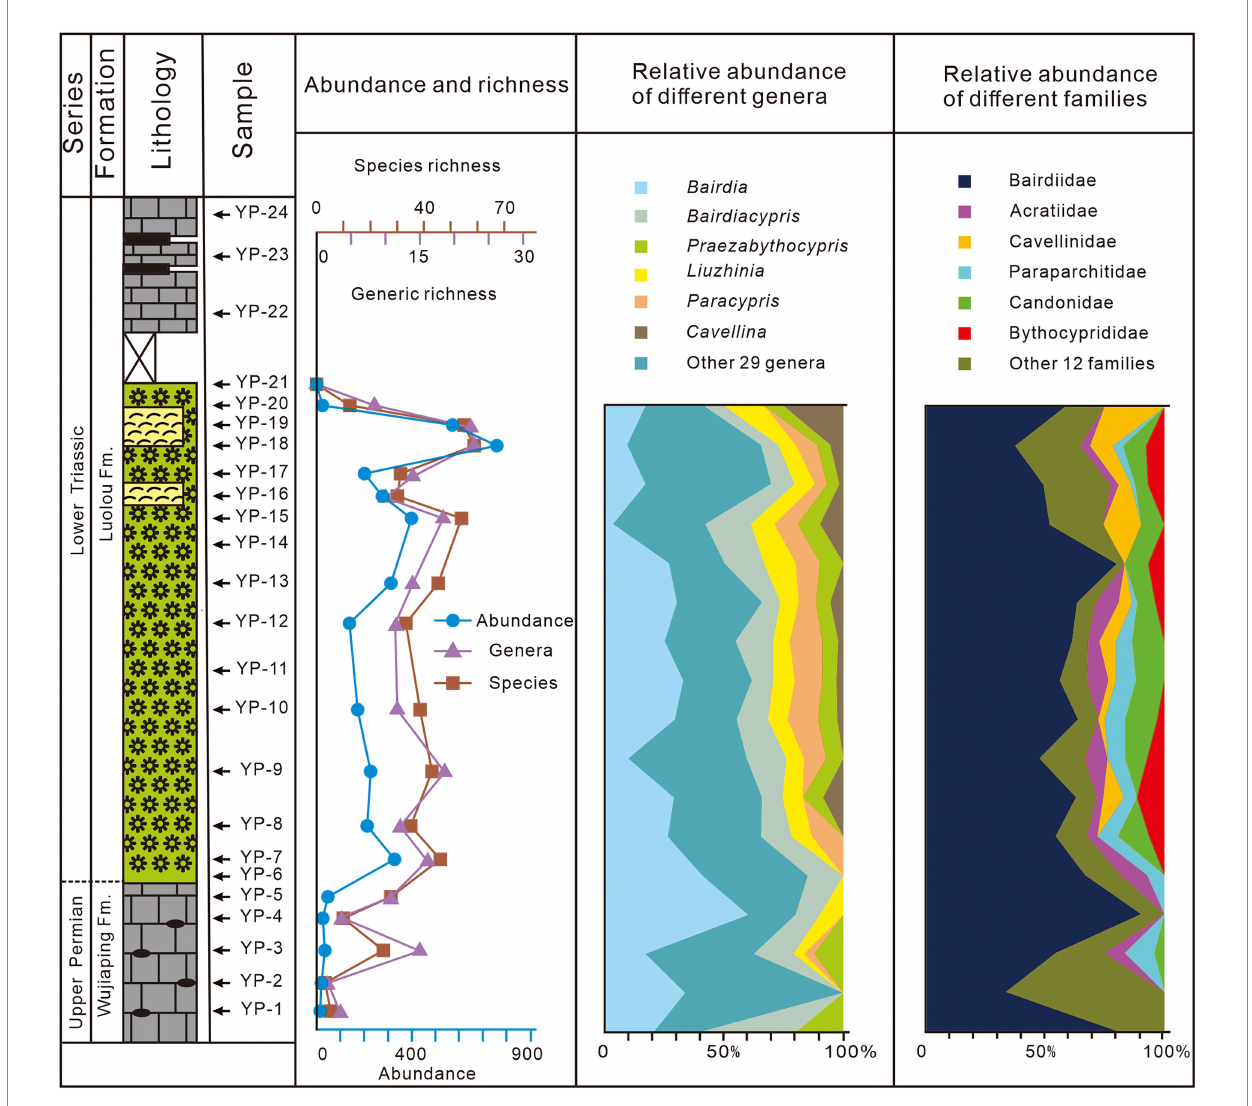
FIGURE 6 Temporal variations of the ostracodal diversity, abundances and compositions throughout the Youping